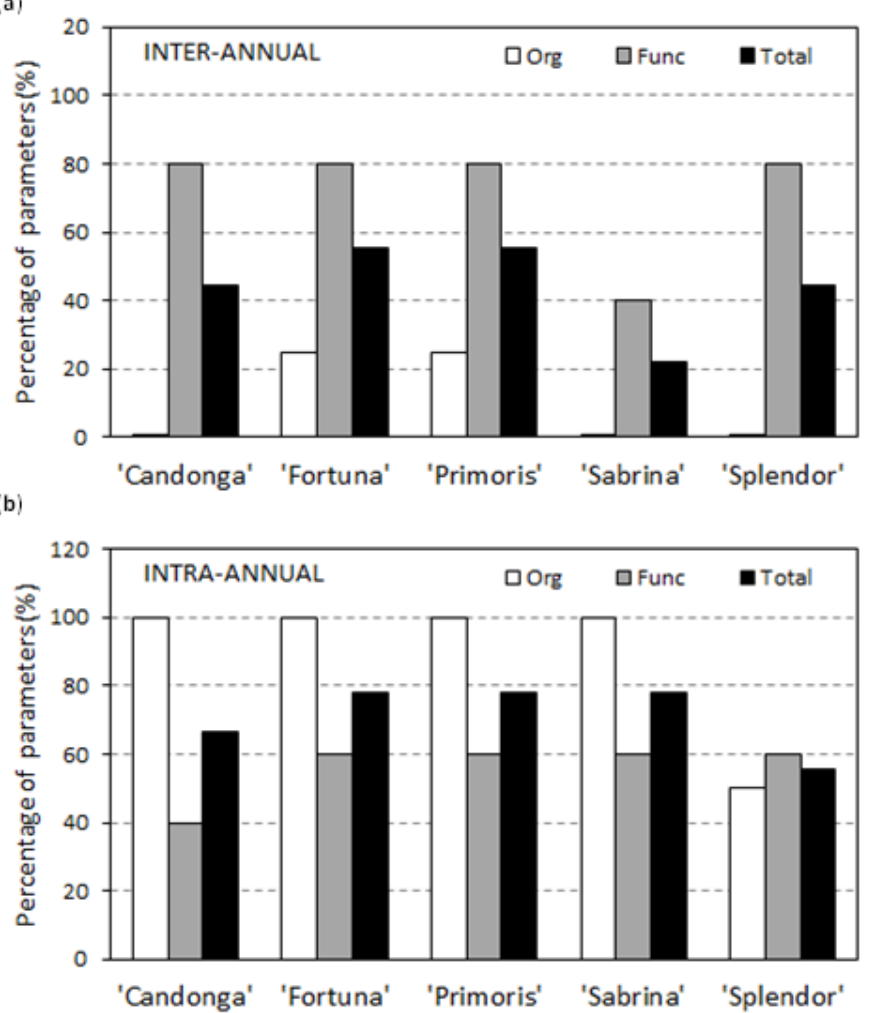
Figure 1. Percentage of organoleptic (Org) and functional (Func) fruit quality parameters showing significant inter- ( a ) and intra- ( b ) annual variation ( p < 0.05) in the five strawberry varieties studied.